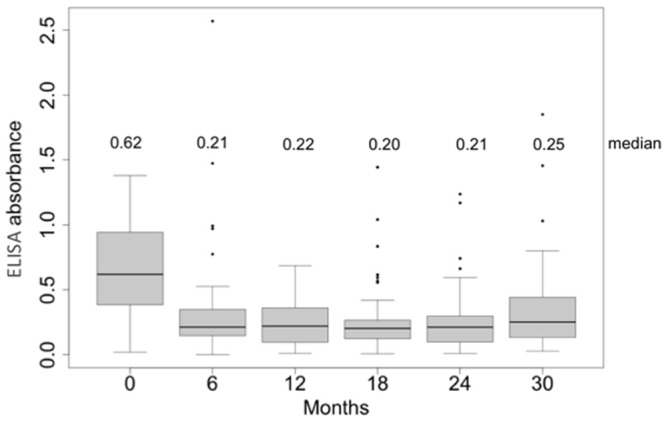
Pre and post-treatment absorbance indexes of ELISA (IgG anti-T.cruzi).